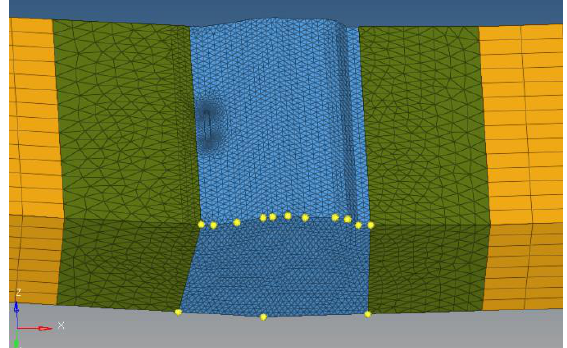
Figure 17. The meshed model of the welded specimen.